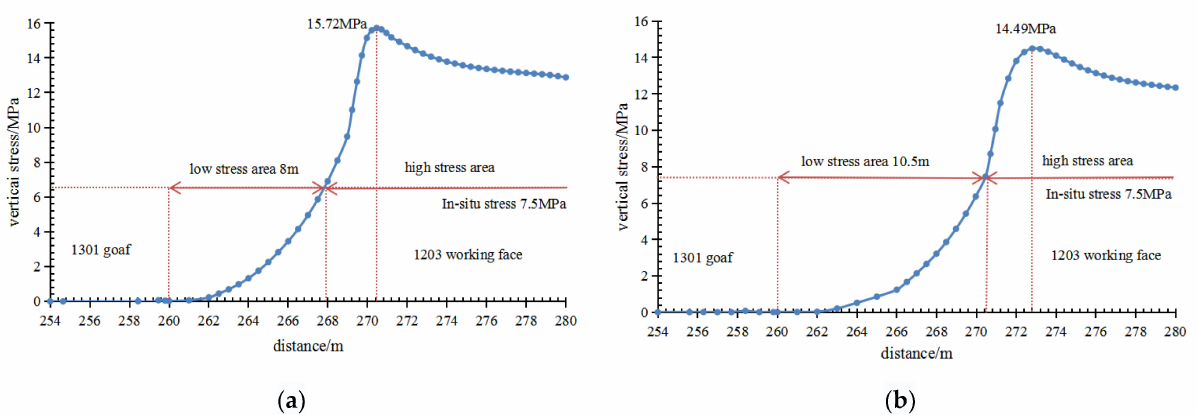
Figure 8. Vertical stress cloud map of the surrounding rock after roof cutting: ( a ) roof cutting height of 6 m (cut to the subkey strata); ( b ) roof cutting height of 12 m (cut to the main key strata).